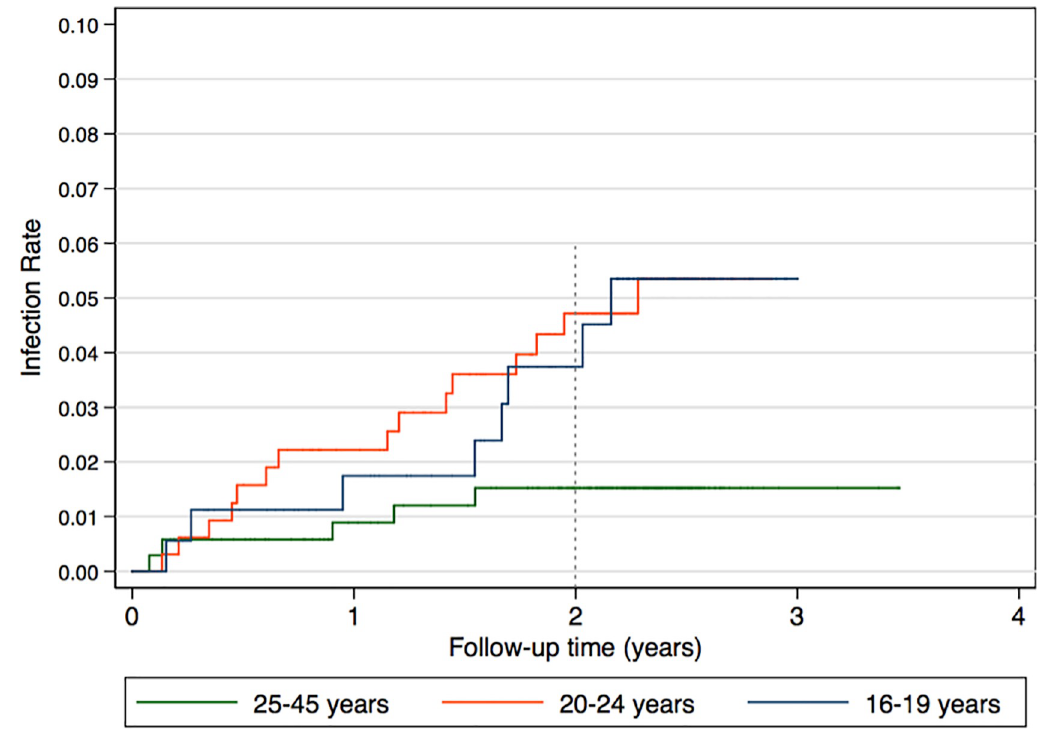
Fig 2. Time to HIV seroconversion by age group of